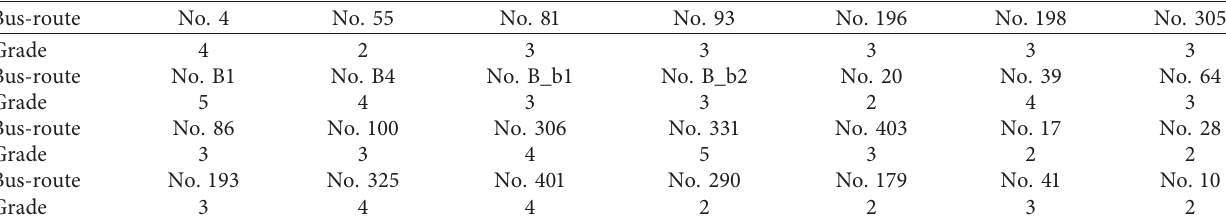
Table 4: Expert evaluation on speed grade of bus line.